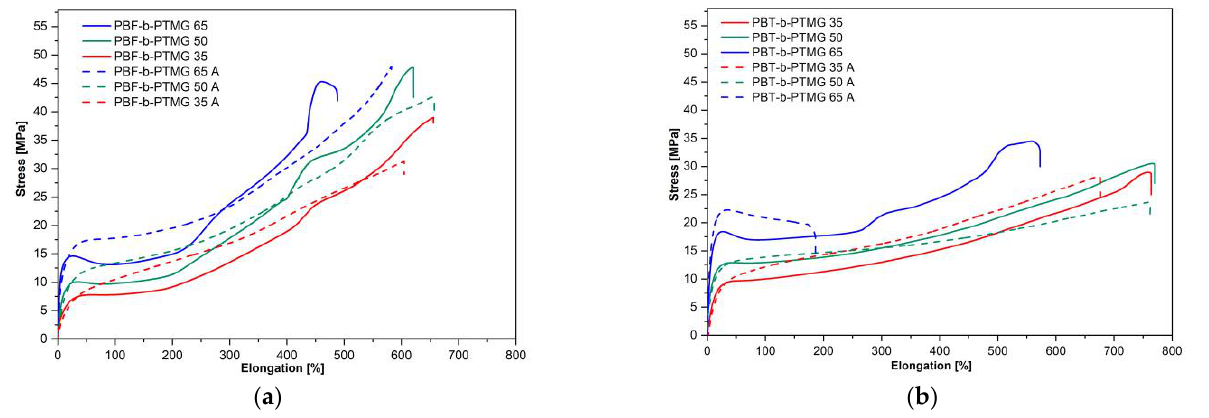
Figure 8. The representative uniaxial stress-strain plots of ( a ) PBF-b-PTMG and ( b ) PBT-b-PTMG copolymers after one month of storage and after annealing (A). Table 3. Mechanical parameters of PBF and PBT based copolymers.